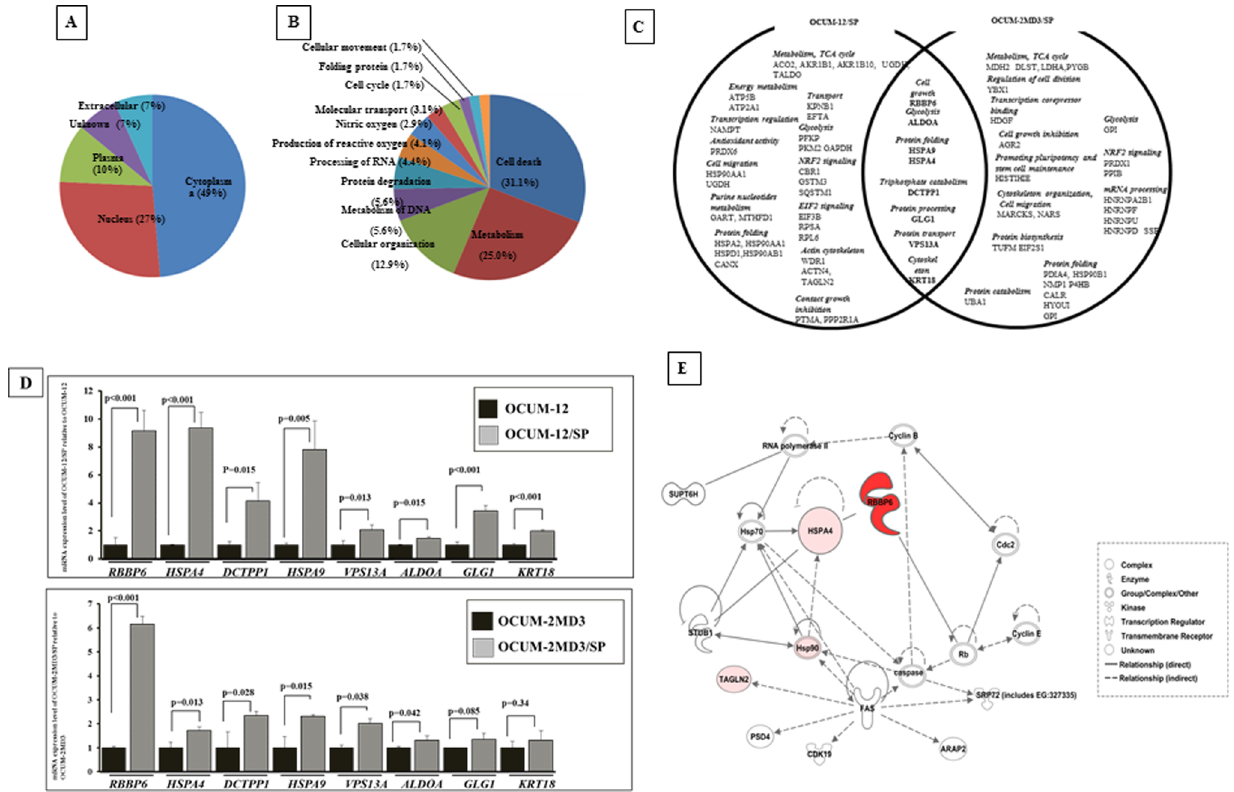
Figure 1. Ingenuity Pathway Analysis (IPA) of Proteins Expressed in SP Cells. (A) Localization; (B) Biological processes of identified proteins. We categorized the proteins based on their functional assignments using Ingenuity Pathway Analysis. The molecular functions reported include cell death, metabolism, cellular organization, metabolism of DNA, protein degradation, processing of RNA, production of reactive oxygen species, nitric oxide, molecular transport, cell cycle, folding protein, and cellular movement. %=100 X number of identified proteins/all 932 proteins analyzed. (C), A Venn diagram confer to Table 2. Forty proteins were significantly increased in OCUM-12/SP cells compared to their parent OCUM-12 cells. Thirty-five proteins were significantly increased in OCUM-2MD3/SP cells compared to their parent OCUM-2MD3cells. Eight candidate proteins, RBBP6, HSPA4, HSPA9, GLG1, DCTPP1, VPS13A, CK18 and ALDOA, overlap in both OCUM-12/SP and OCUM-2MD3/SP cells. (D), mRNA expression. RT-PCR analysis indicated that the expression level of RBBP6, HSPA4, DCTPP1, HSPA9, VPS13A, ALDOA, GLG1 , and CK18 was high in OCUM-12/SP (9.15 fold, 9.36 fold, 4.14 fold, 7.80 fold, 2.08 fold, 1.46 fold, 3.44 fold, and 1.99 fold, respectively) and OCUM-2MD3/SP (6.15 fold, 1.71 fold, 2.33 fold, 2.30 fold, 2.03 fold, 1.32 fold, 1.35 fold, and 1.31 fold, respectively), in compared with the control of parent OCUM-12 and OCUM-2MD3. (E), Correlation of Signaling Pathways between RBBP6 and Differentially-Expressed Proteins in CSC-like SP cells. RBBP6 is over-expressed (red) in CSC-like SP cells (OCUM-12/SP cells and OCUM-2MD3/SP cells). Hsp90, HSPA4, and TAGLN2 (pink) up-regulated in CSC-like SP cells were associated with the RBBP6 signaling pathway.